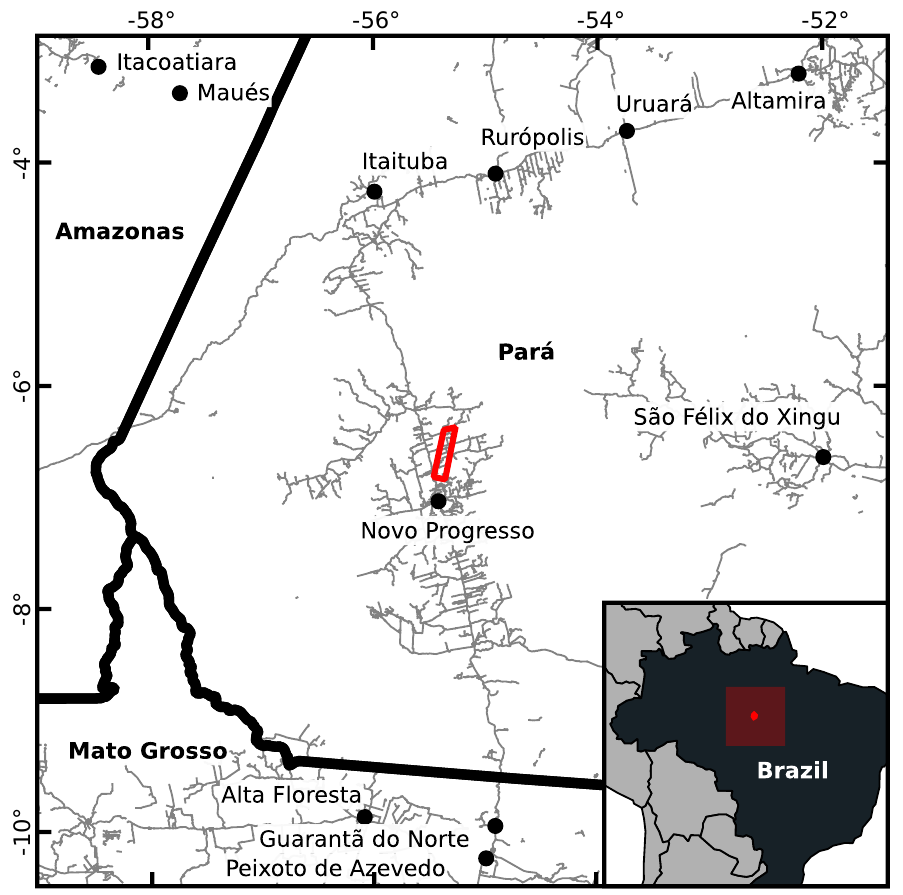
Figure 1. The study area is defined in an area of severe LULC processes and as the intersection of the available L-, C-, and X-band